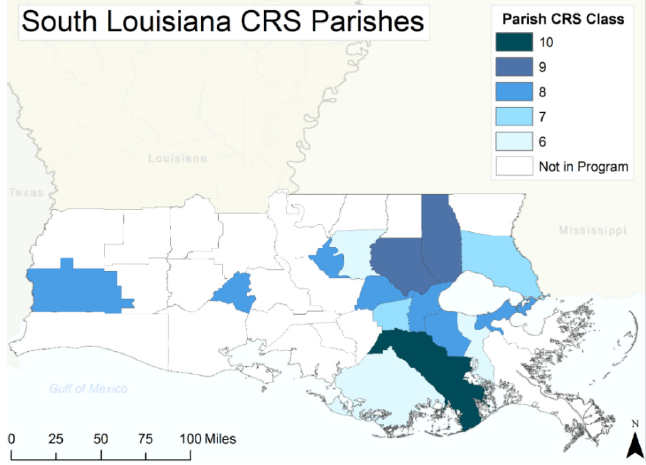
Figure 1. Map of the study area with CRS participating counties coded by CRS class ranking.